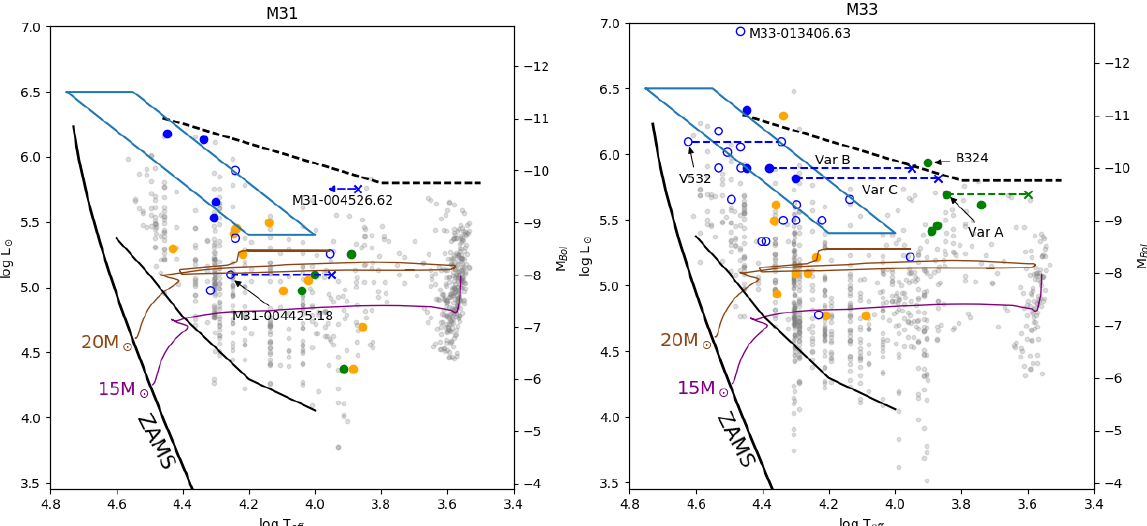
Figure 4. The schematic HR Diagrams for M31 and M33 showing the positions of the confirmed LBVs and candidate LBVs shown respectively, as filled and open blue circles, the warm hypergiants as green circles and the B[e] supergiants as orange circles. The LBV transits during their high mass loss state are shown as dashed blue lines. The LBV/S Dor instability strip is outlined in blue. The 15 and 20 M (cid:12) tracks are from [87] with rotation are shown to provide a reference for the lower mass B[e]sgs, which are probable rotators. (Higher mass tracks are not shown due to crowding.) The supergiant population is shown in the background in light gray. Reproduced from